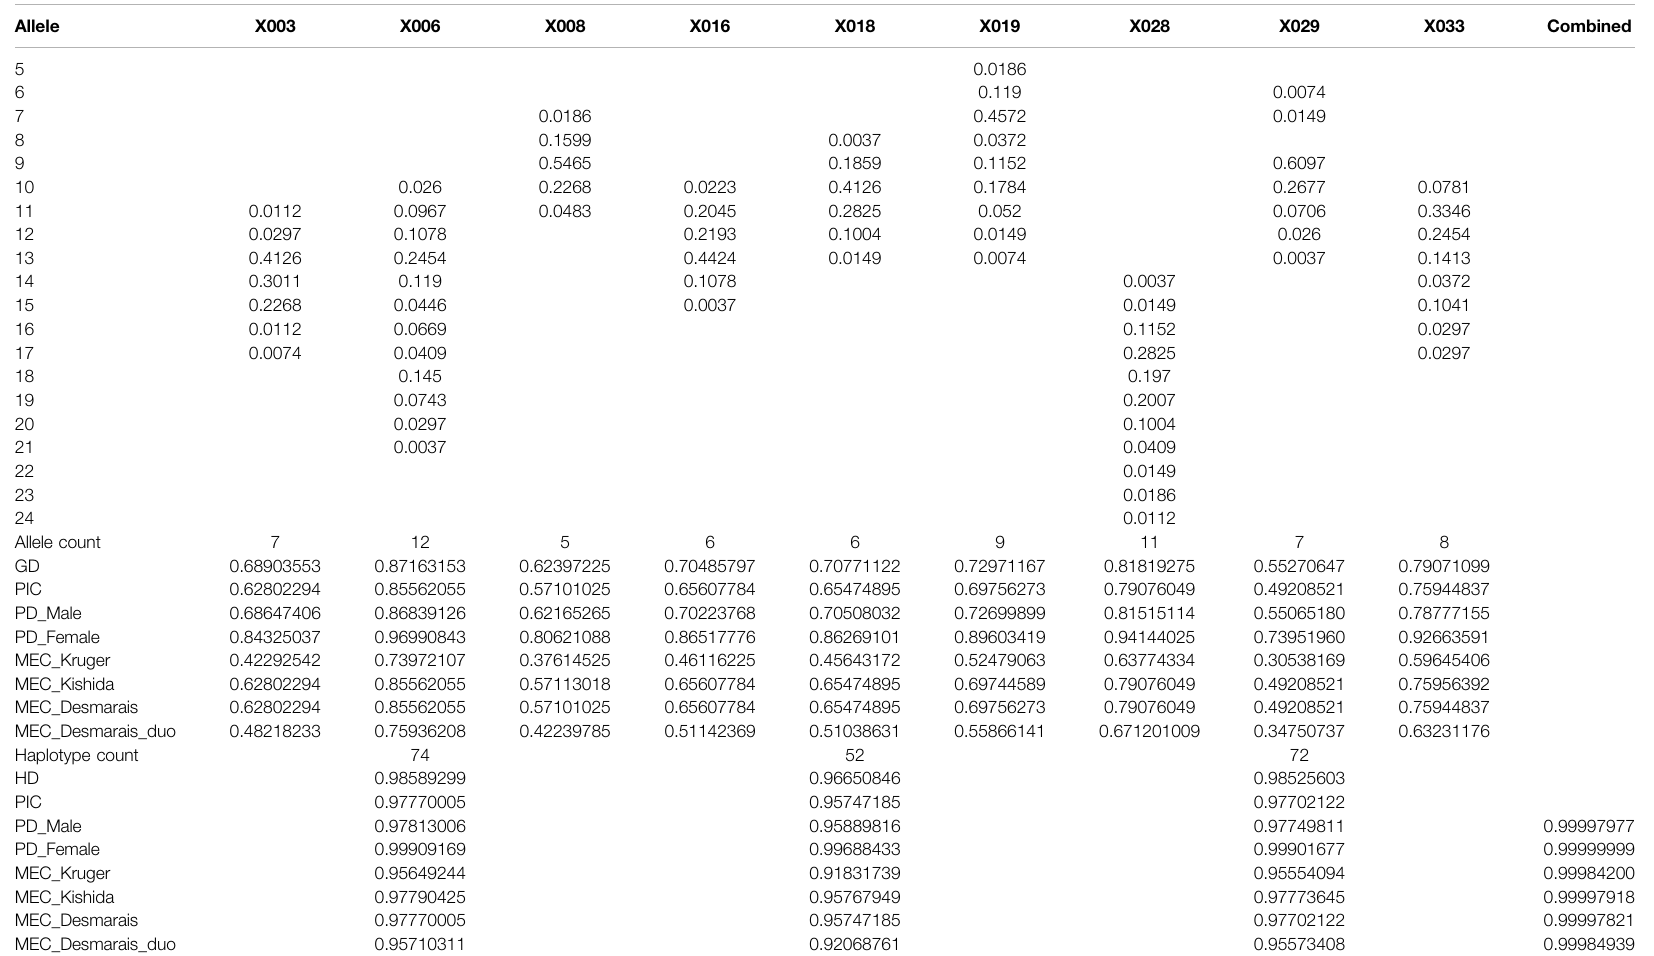
TABLE 3 | Allele frequencies and forensic parameters of the nine X-STRs and haplotypes.